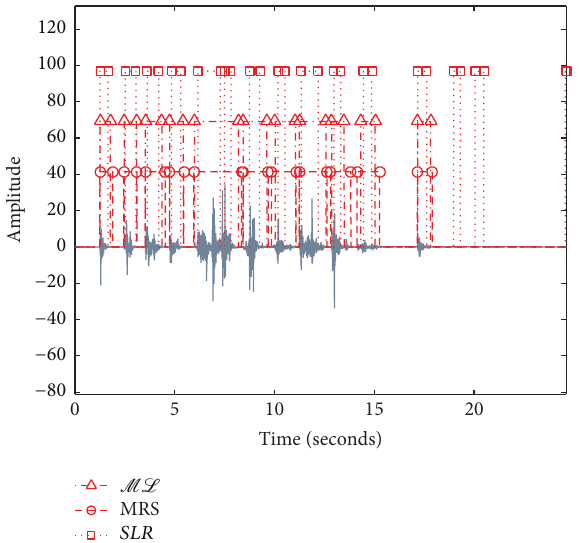
Figure 15: The comparison of the discussed segmentation methods applied to the real data containing several seismic